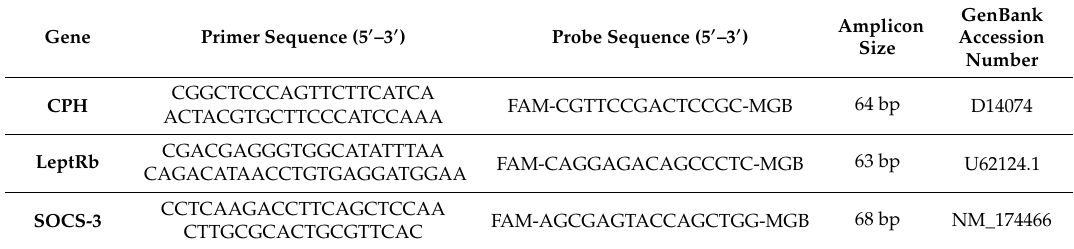
Table 1. Characteristics of primers and probes used to determine cyclophilin (CPH; reference gene), the long form of the leptin receptor (LeptRb; target gene), and a suppressor of cytokine signaling-3 (SOCS-3; target gene) mRNA expression in